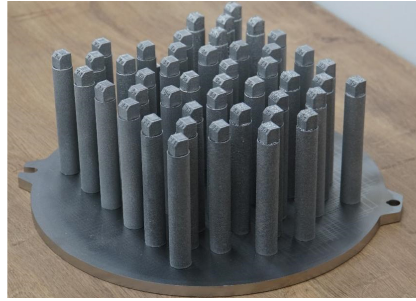
Figure 1. 45 Ti ‐ 6Al ‐ 4V samples